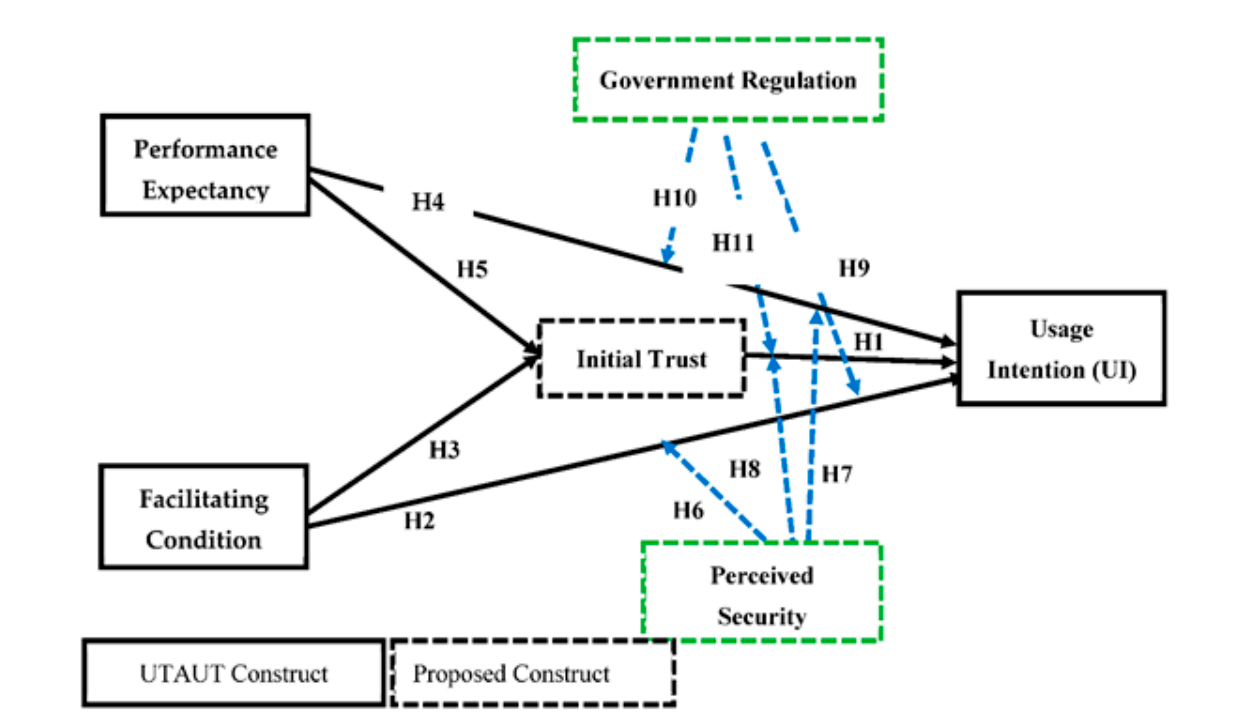
Figure 1. Conceptualized extended UTAUT model.